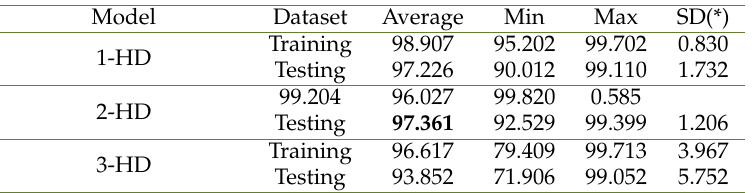
Table 8. Summary of the 1000 simulations using VAF criteria Model